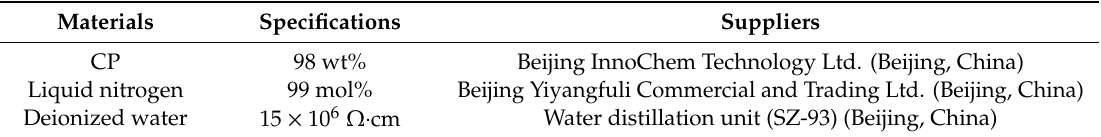
Table 1. Sources and specifications of the experimental gas and